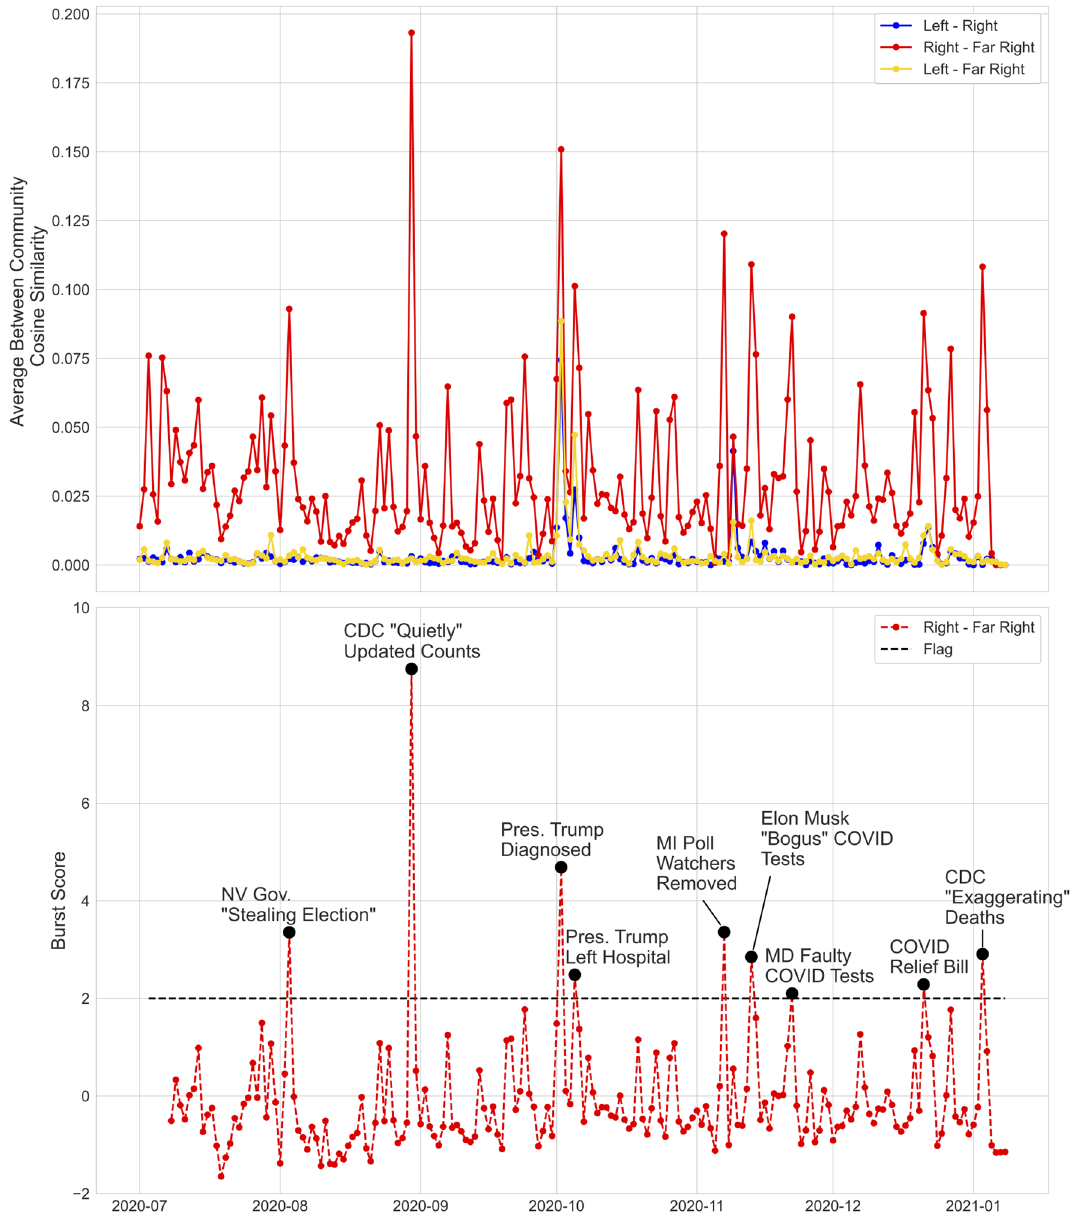
Figure 6. Top. Average inter-cluster similarity between the Left, Right, and Far-Right clusters for each day between July 1, 2020 and January 6, 2021. Bottom. Inter-cluster burst score [Equation (1)] between the Right and Far Right. Annotated days represent days in which the burst score is greater than or equal to 2. The first seven days of the observation period are omitted to establish and Far Right clusters have a non-zero baseline similarity and exhibit multiple days of similarity exceeding 0.10. Additionally, time points are observed where similarity spikes between the Right and Far Right. These bursts may represent emerging content garnering support across different segments of the online ecosystem. We used a modification of the burst score of Mehrotra et al 33 to identify time points for which inter-cluster similarity is unusually large. Define